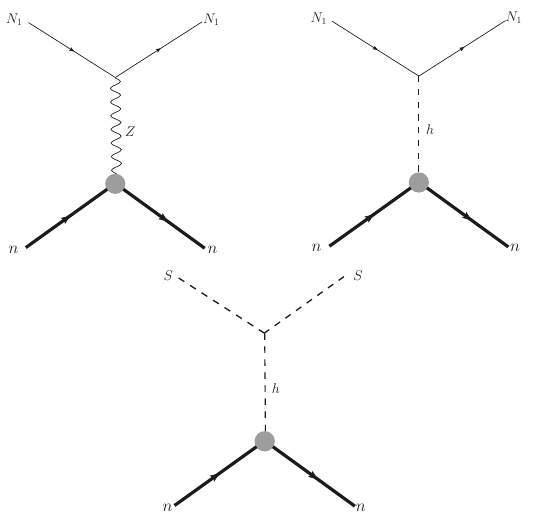
Figure 8 . Sensitivity of mediator mass ( m (cid:31) ) to DM-DM conversion and that to relic density of 2 the heavier component is demonstrated. [Left] (cid:10) N h 2 as a function of m N for di(cid:11)erent values of 1 1 m (cid:31) = 500 (red) ; 1000 (green) ; 2000 GeV (blue) assuming m N > m S . [Right] (cid:10) S h 2 as a function 2 1 of m S for m S > m N . Other parameters kept (cid:12)xed at di(cid:11)erent values are mentioned in the plot 1 along with Y 2 = 1 : 0 and (cid:21) SH = 0 : 1. Purple dotted line in both graphs correspond to Y 2 = 0 case, shown for comparison. N 1